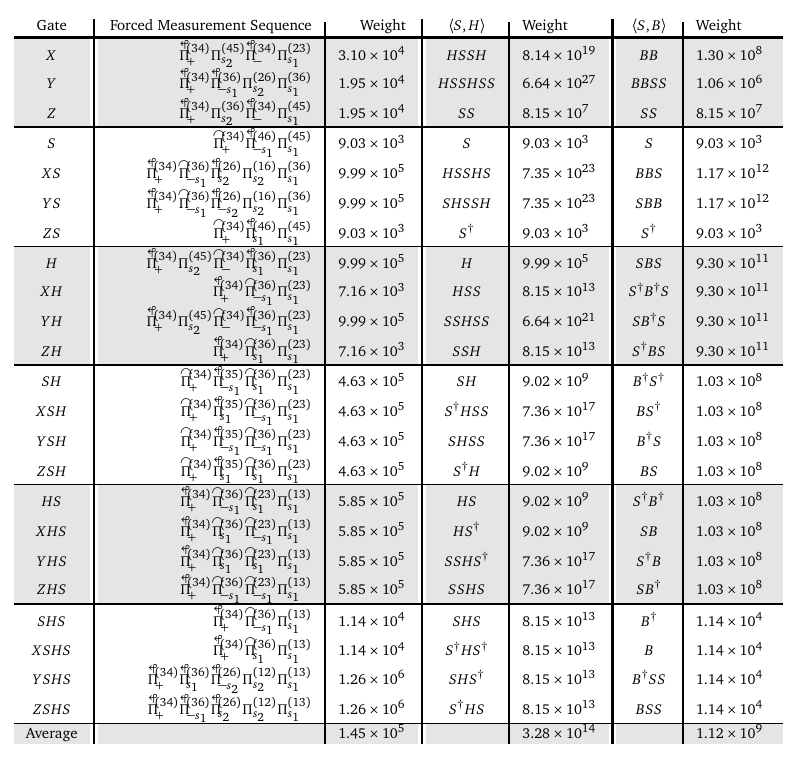
Table 13: Minimal difficulty weight measurement sequences for each single-qubit Clifford gate when using forced-measurement methods. For comparison, we also present the corresponding realization of the gates formed by using the generating gate sets 〈 S , H 〉 and 〈 S , B 〉